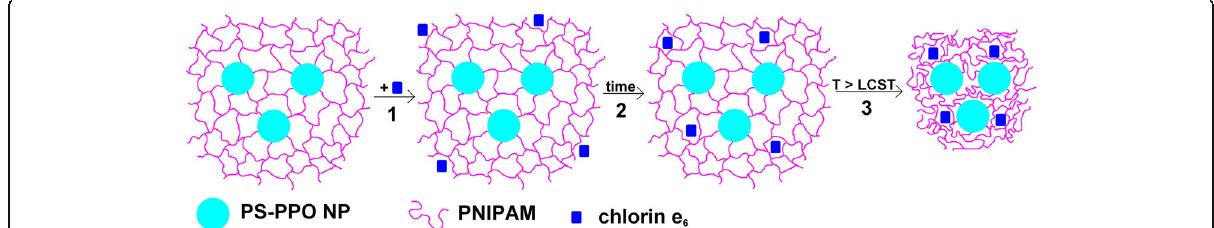
Fig. 10 Proposed scheme of the processes in the solution of PS-PPO-PNIPAM hybrid NS in the presence of chlorin e 6 upon addition of chlorin e 6 (process 1), passing of about 1 h (process 2) and further heating from 23 to 39 °C (process